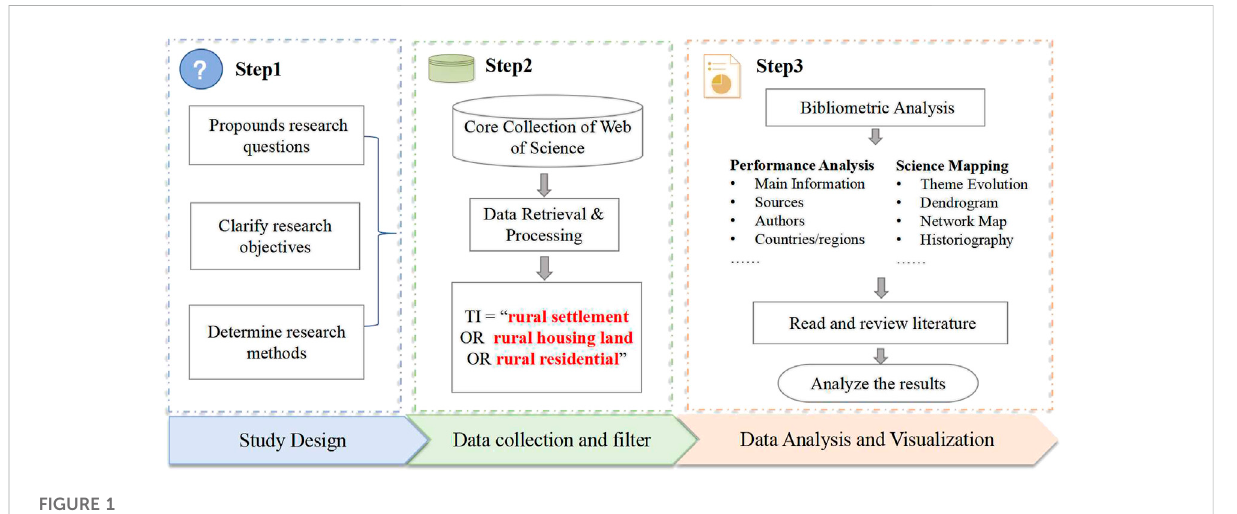
Research design and work fl